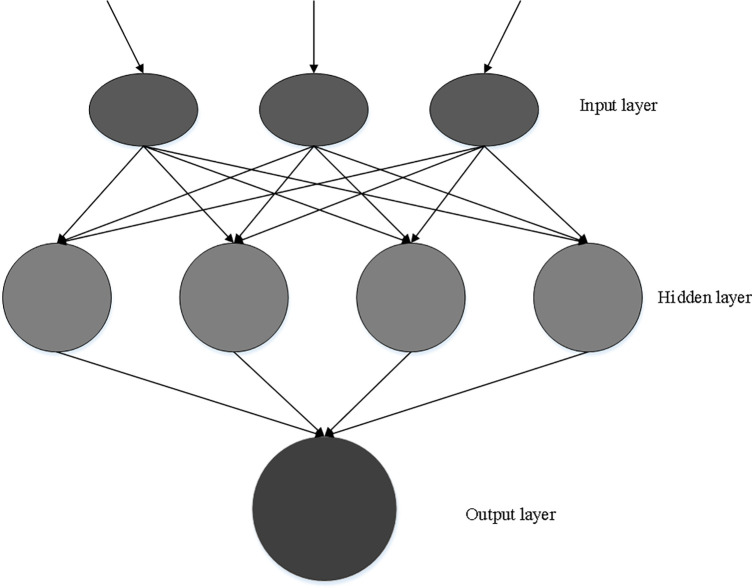
Basic structure of radial basis function neural network.